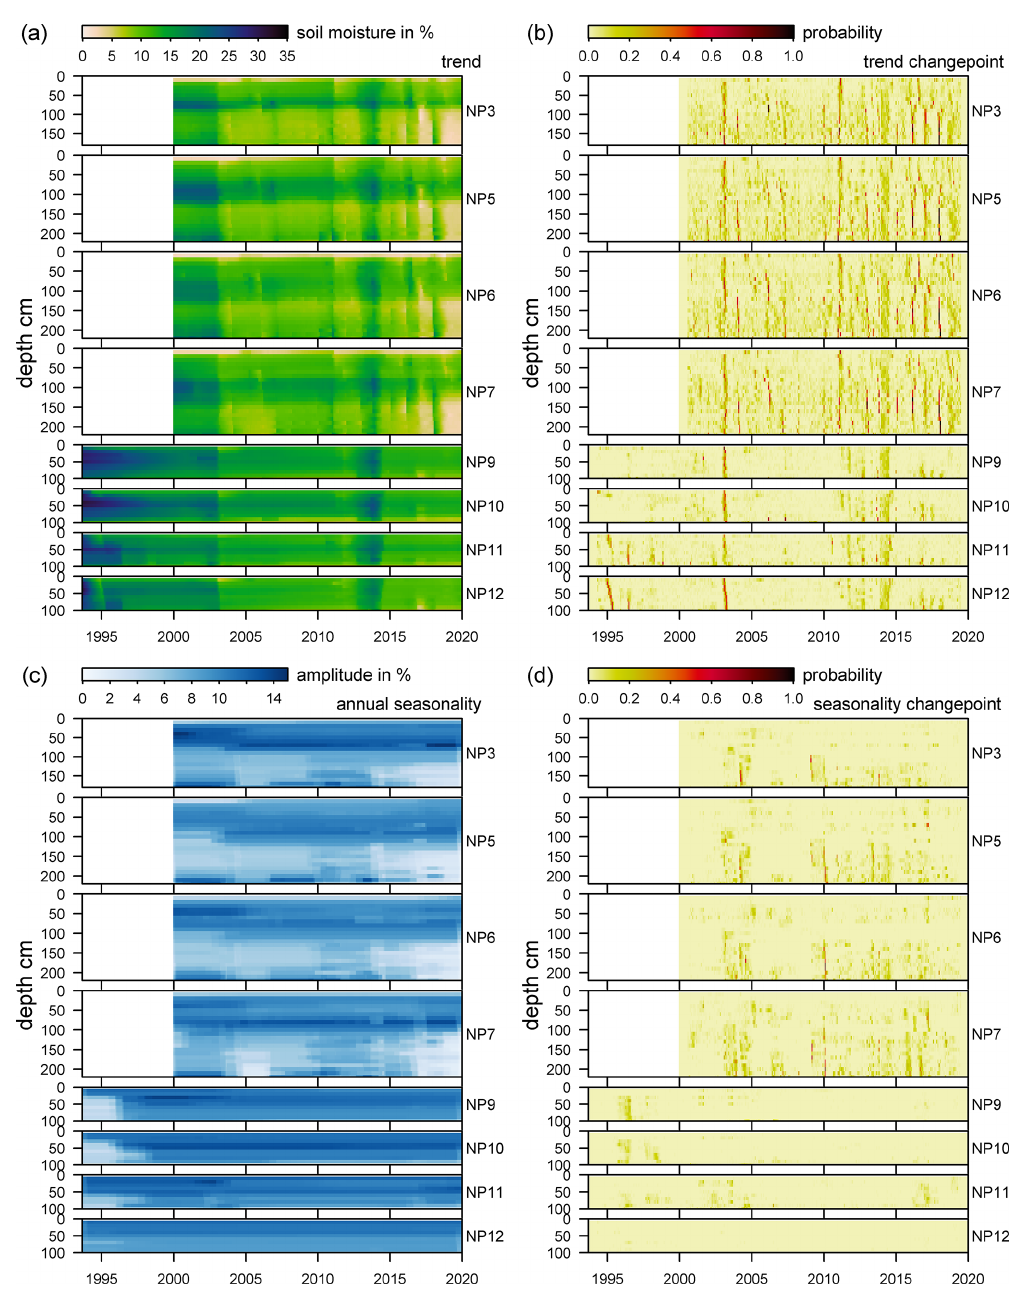
Figure A5. Results of modeling soil moisture with Rbeast. (a) Trend component of the soil moisture time series. (b) Probability of a change point in the trend component. (c) Amplitude of annual seasonality derived from the seasonal component. (d) Probability of a change point in the seasonality